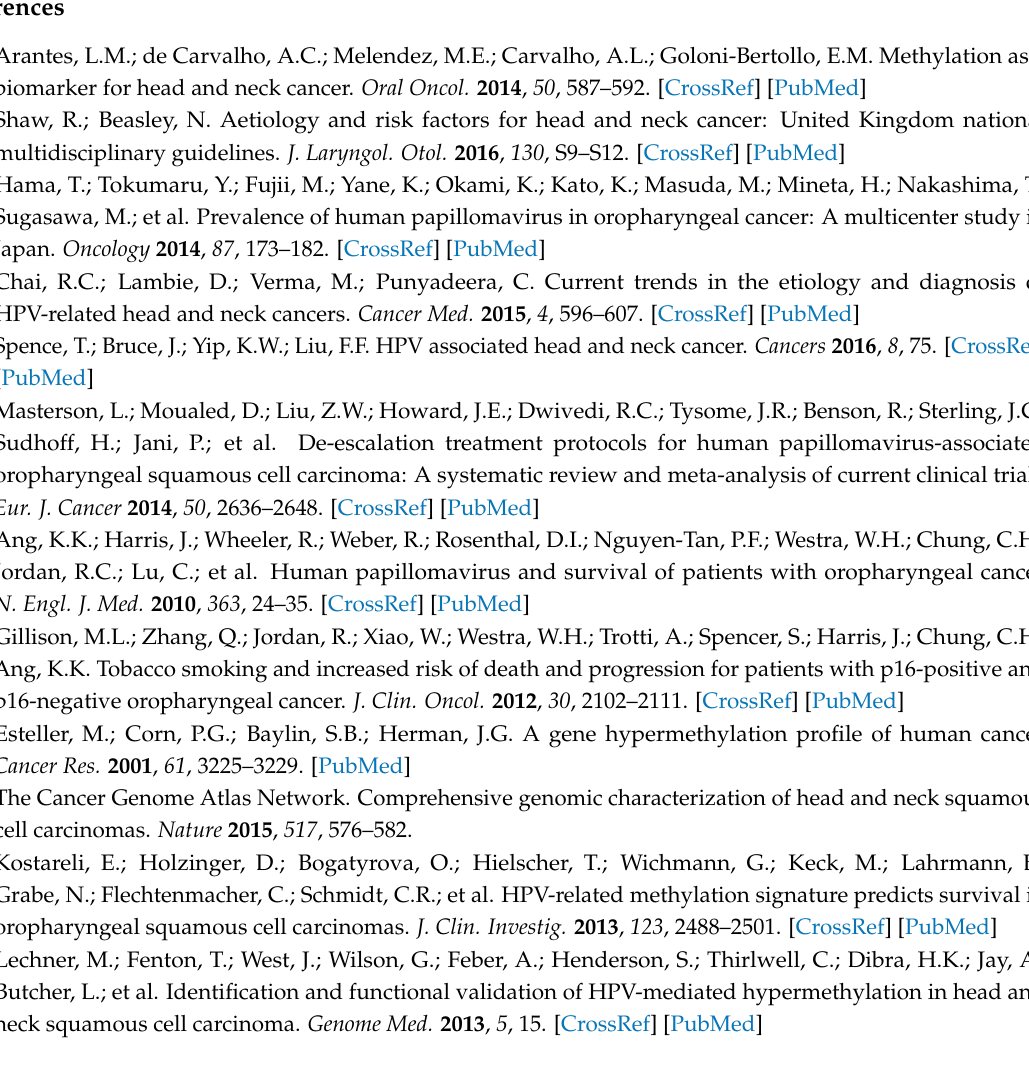
s1. Figure S1: Methylation status of the 30 TRGs in HNSCC and normal samples in TCGA database. The Table S1: Q-MSP Primer